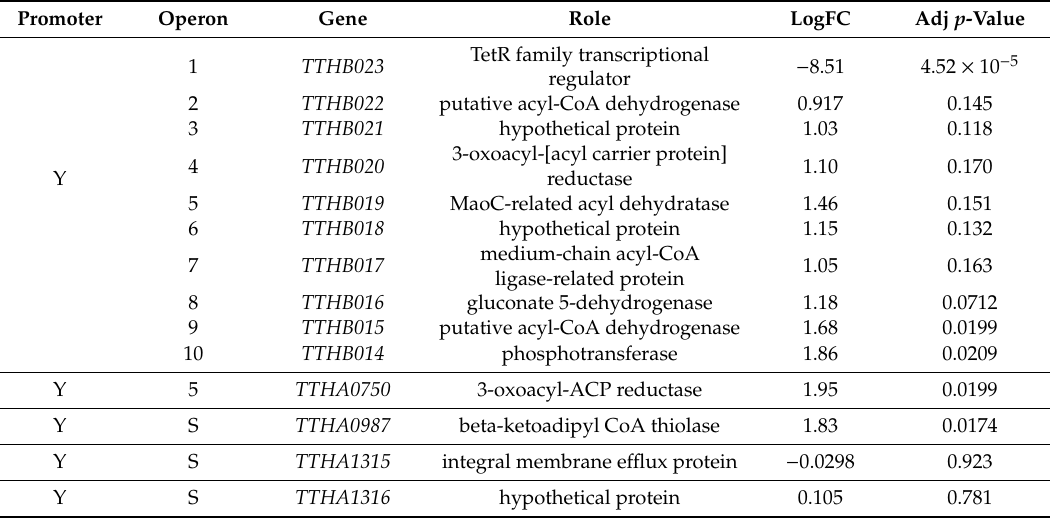
Table 5. TTHB023 potential regulated